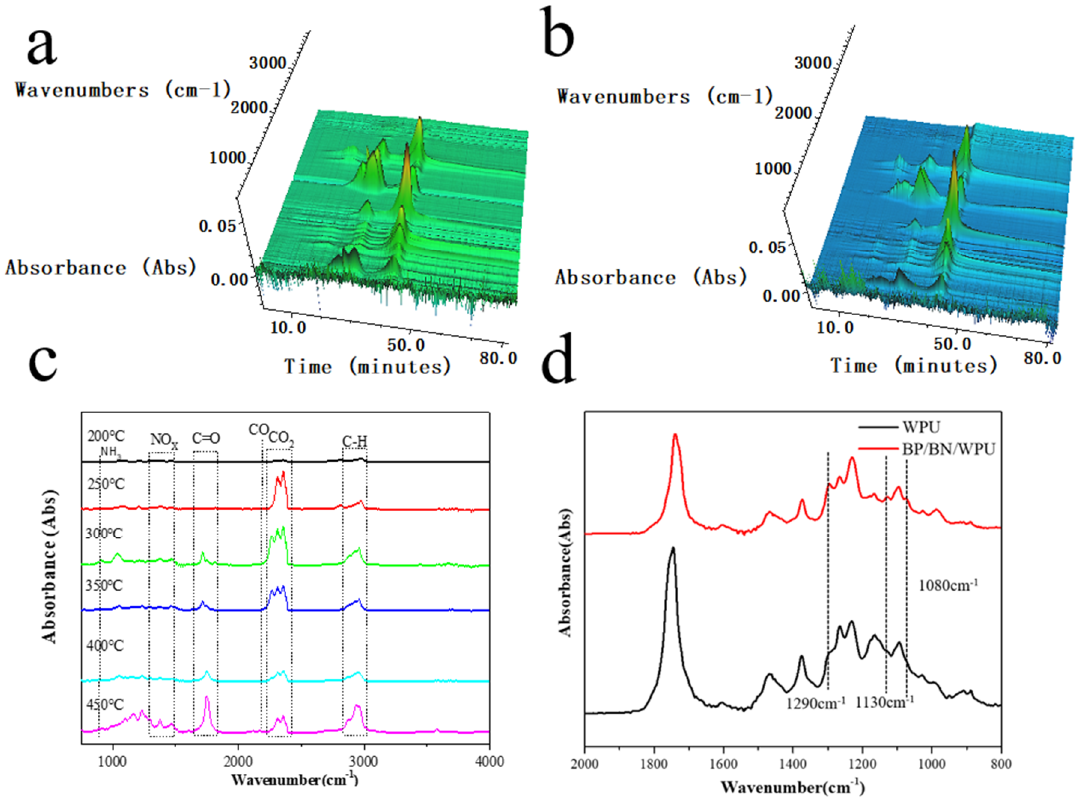
Figure 7. ( a ) 3D image of FTIR spectra of the WPU; ( b ) 3D image of FTIR spectra of the BP/BN/WPU; ( c ) The FTIR spectra of BP/BN/WPU obtained at different temperatures; ( d ) The enlarged image for comparison of the biggest mass loss in the second TG stages of the pure WPU and BP/BN/WPU.